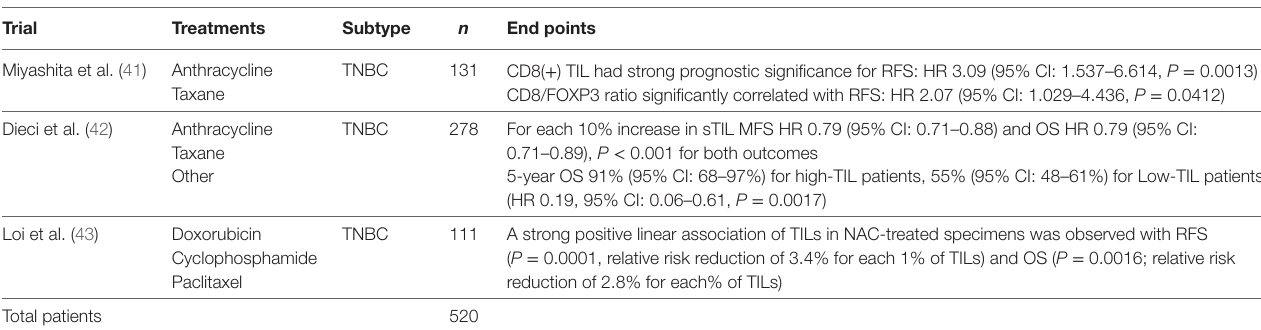
TABLe 3 | Tumor-infiltrating lymphocytes (TILs) in residual disease post neoadjuvant treatment.